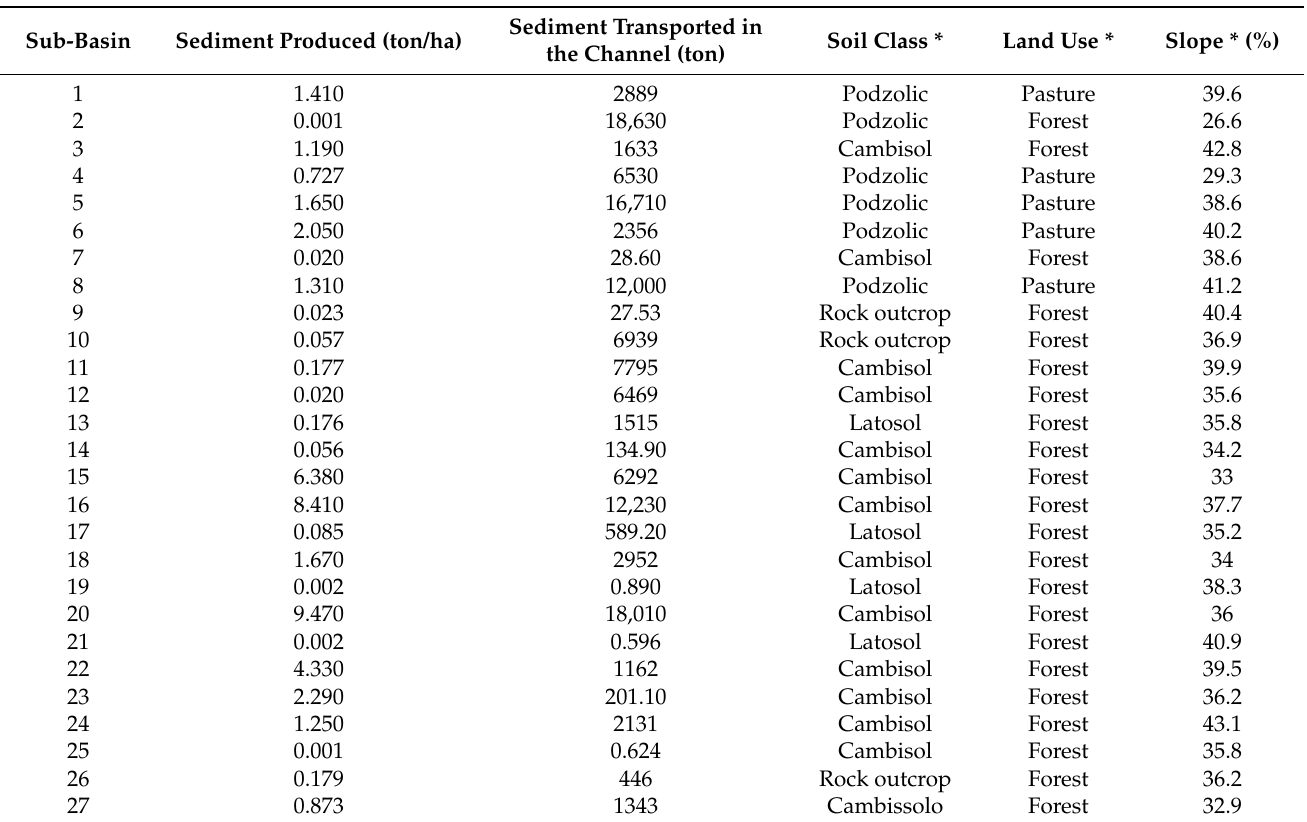
Table 5. Sub-basin sediment production and transport in the main channel.